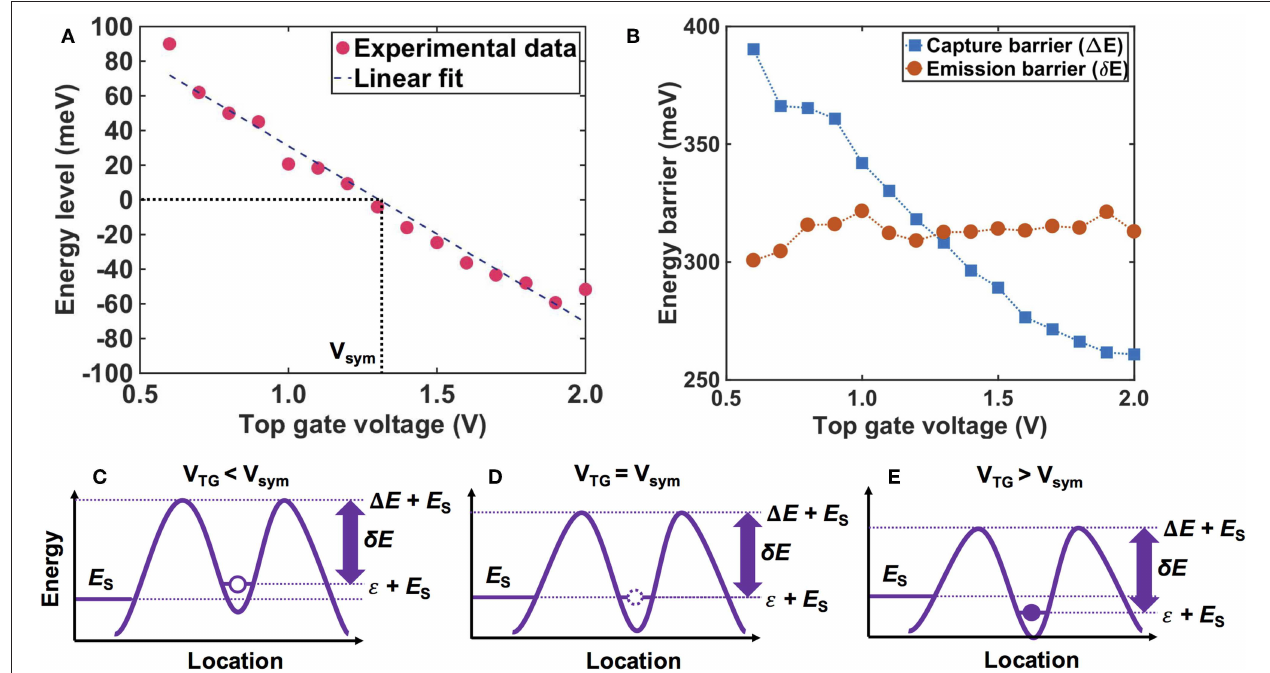
FIGURE 6 | Capture and emission mechanism of an electron from estimated energy barriers. (A) The energy level in the QD against V TG calculated using Equation (7). The filled circles are extracted from the ratio of the lifetimes, while the broken line is the linear fit of the data. V sym is the voltage value when the energy level is completely aligned to the conduction band bottom of source, which is around 1.3 V. (B) The energy barriers for an electron to be captured and to be emitted from the quantum dot. The capture barrier 1 E and the emission barrier δ E = 1 E − ǫ are plotted against V TG as squares and filled circles, respectively. The dotted lines are visual guides. (C–E) The energy diagram inferred from the estimated energy barriers, depending on V TG with respect to V sym